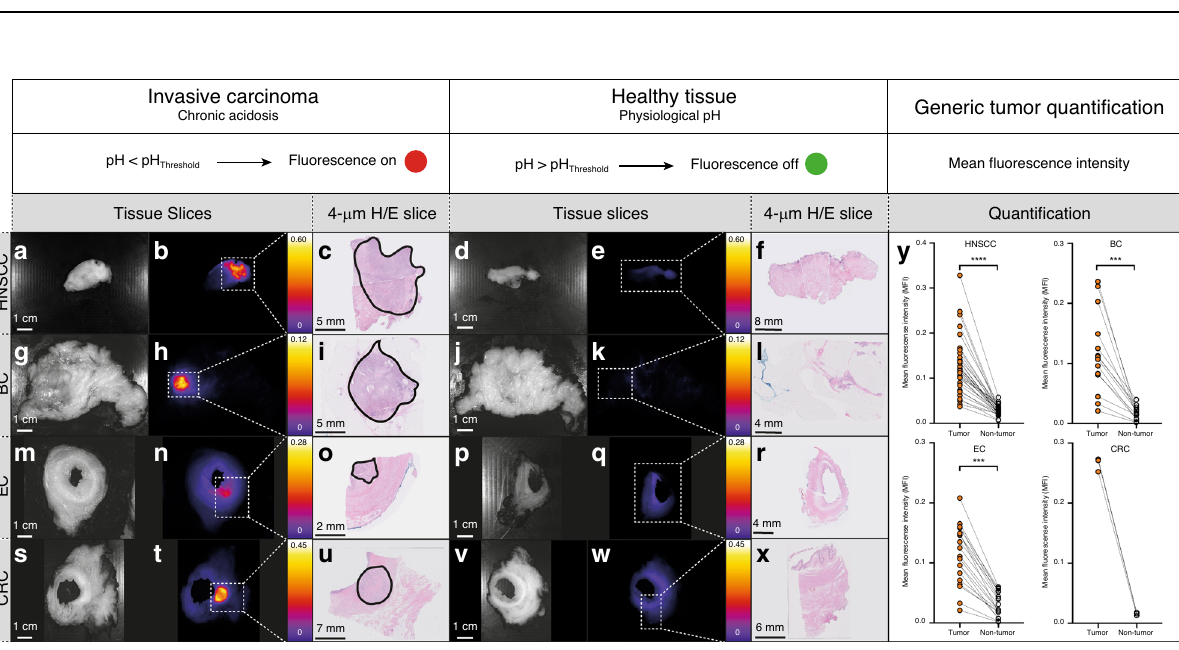
Fig. 3 Fluorescence images of different tumor tissue slices. Head and neck squamous cell cancer of the tongue ( a – f ); breast cancer ( g – l ); esophageal cancer ( m – r ); colorectal cancer ( s – x ). The tumor is delineated as a solid black line in the H/E slices ( c , i , o , u ). The mean fl uorescence intensity (MFI) of the tumor tissue and the non-tumor tissue slices, per tumor type, is depicted ( y ). The dots represent the MFI of single tissue slices ( ≈ 3 per subject) from the 1.2 mg per kg cohort. HNSCC, 7 subjects, P < 0.0001, BC, 5 subjects, P = 0.0001, EC, 3 subjects, P = 0.0010, and Wilcoxon test, two-sided. CRC, 3 subjects, no statistics performed due to the availability of only three data points. HNSCC head and neck squamous cell cancer, BC breast cancer, EC esophageal cancer, CRC colorectal cancer, H/E hematoxylin eosin. *** P ≤ 0.001; **** P ≤ 0.0001. Source data are provided as a Source data fi le. Table 3 Contingency table for fl uorescence-guided surgical margin